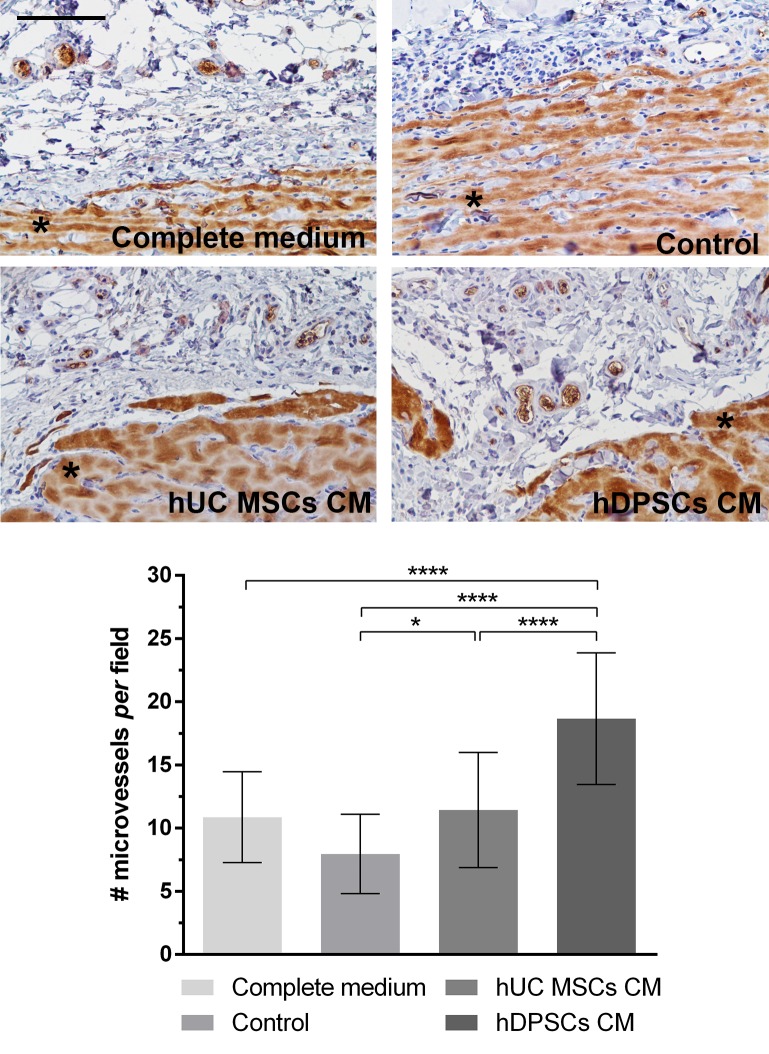
In vivo re-vascularization (Matrigel® Plug) assay.After 7 days of implantation of Complete, Control, UC-MSCs or DPSCs supplemented media groups. VEGFR2 immunohistochemical staining (upper panel); *: background uptake of DAB chromogen by the Matrigel®. Graphical representation of VEGFR2 immunopositive microvessels per field (#) observed in each group (lower panel) (scale bar = 100 μm). Values are presented as Mean ± SD. Significant differences indicated according to P values with one, two, three or four of the symbols (*) corresponding to 0.01≤P<0.05; 0.001≤P<0.01; 0.0001≤P<0.001 and P<0.0001, respectively.